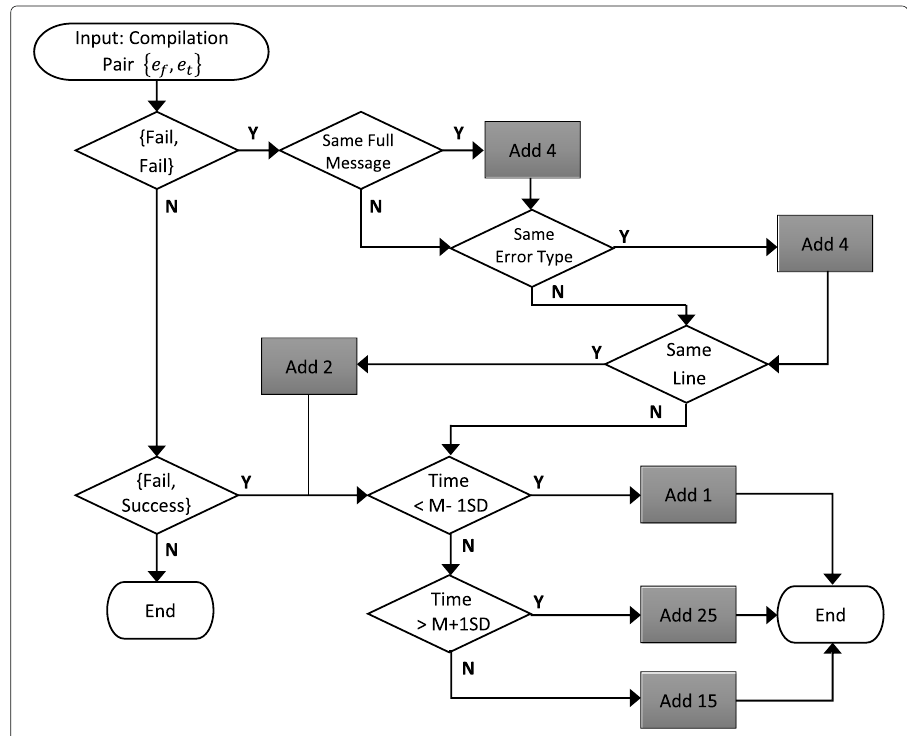
Fig. 4 The Watwin Score algorithm